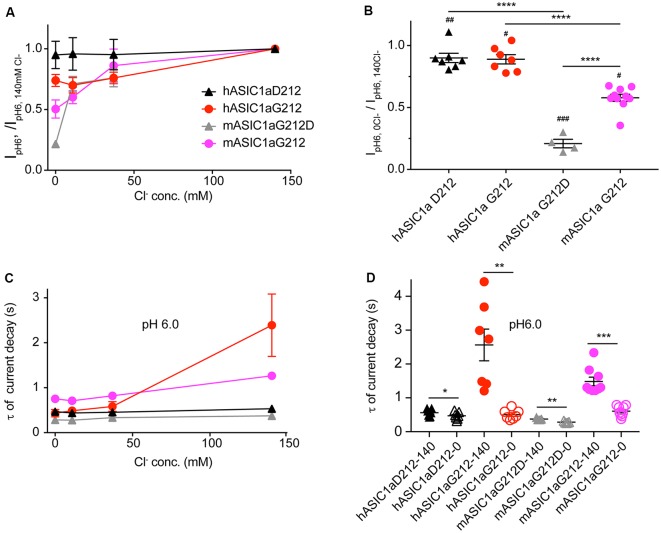
The chloride concentration affects the current decay kinetics in human and mouse ASIC1a-G212. All data in this figure are from human or mouse ASIC1a expressed in CHO cells, measured with whole-cell patch-clamp; black symbols represent hASIC1a-D212, red symbols hASIC1a-G212, gray symbols mASIC1a-G212D and purple symbols mASIC1a-G212. Conditioning pH was 7.4 in all experiments. Chloride in the extracellular solutions (conditioning and stimulating) was replaced in part or completely by SCN−, as indicated. (A) The IpH6.0 measured at a given Cl− concentration is normalized to the IpH6.0 measured in normal extracellular medium containing 140 mM Cl− in the same cell, shown for the four constructs, n = 4–5. (B) The ratio of the IpH6.0 measured in 140 mM SCN−/0 Cl−/IpH6.0 measured in 140 mM Cl−/0 SCN− is plotted. Statistical analysis with paired t-tests showed that in all four constructs, the change in ion affected the current amplitude: #p < 0.05, ##p < 0.01, ###p < 0.001. Differences between constructs (ANOVA followed by Tukey post-test) are indicated, **p < 0.01, ****p < 0.0001. (C) Time constants of current decay, derived from single-exponential fits, obtained with different anion concentrations as indicated, at pH6, n = 4–5. (D) Time constants of current decay, shown for each of the constructs at 0 and 140 mM Cl−, at pH6. Differences between the two ion conditions of a given construct are *p < 0.05, **p < 0.01 or ***p < 0.001, determined by ANOVA followed by Tukey post-test.